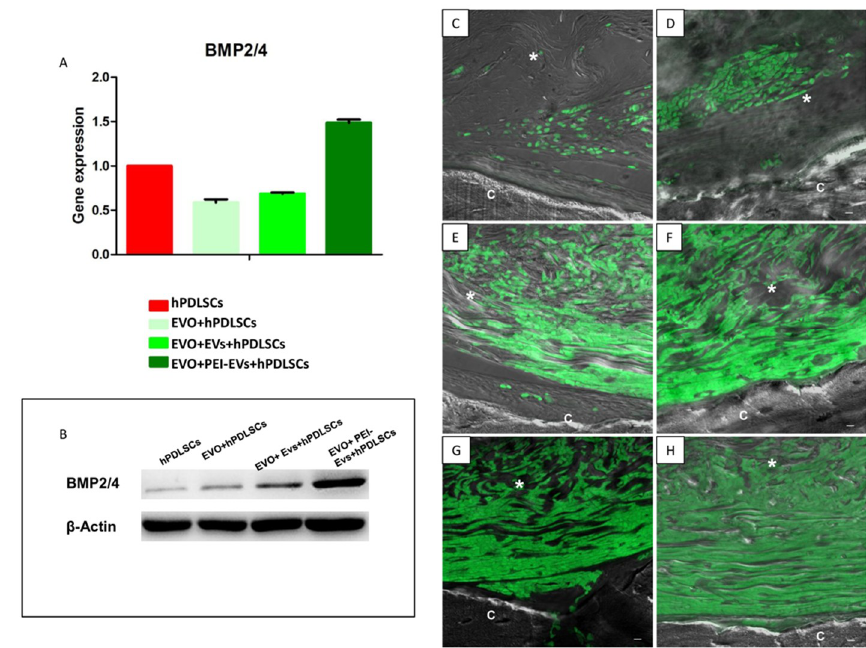
Figure 3. Collagen-based membrane in vivo functional evaluation. ( A ) Real time-PCR graph of BMP2 / 4 expression in di ff erent experimental groups after six weeks of in vitro culture ( n = 3). ( B ) Western blot analysis of BMP2 / 4. Immunofluorescence staining of BMP2 / 4 showed the presence of the protein in semithin section samples obtained after six weeks of grafting in rat calvaria in ( C ) EVO, ( D ) EVO + hPDLSCs, ( E ) EVO + EVs, ( F ) EVO + EVs + hPDLSCs, ( G ) EVO + PEI-EVs and ( H ) EVO + PEI-EVs + hPDLSCs. Magnification: × 20; C, mouse calvarium; *, EVO. figure published in reference